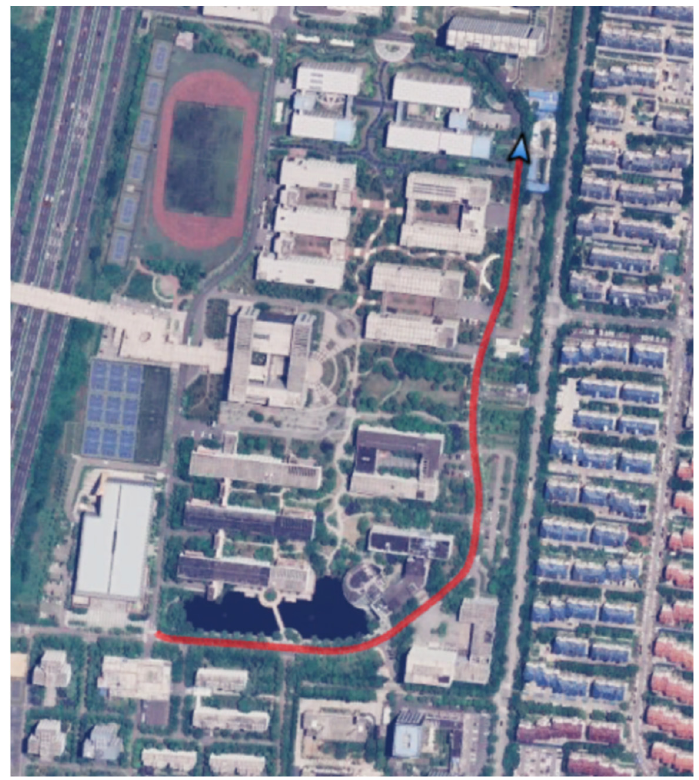
Figure 7. The experimental trajectory. Figure 8 illustrates the positions generated by the different methods.